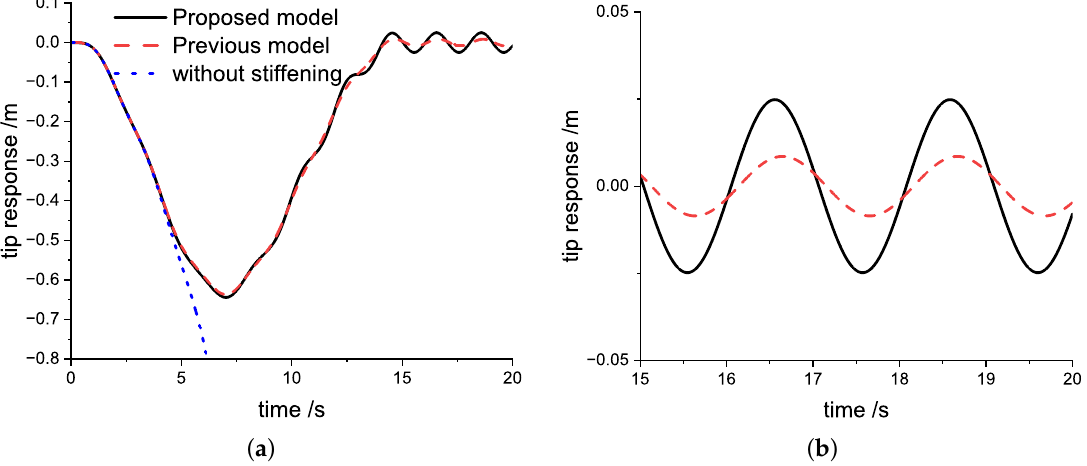
Figure 4. The response of the beam’s free end when Ω 0 = 4 rad/s: ( a ) Full time period; ( b ) Magnification of the uniform rotating stage.